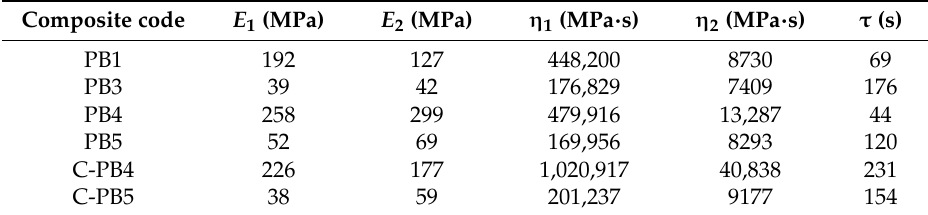
Table 2. Parameters of the mechanistic Burger model, creep component of composites.